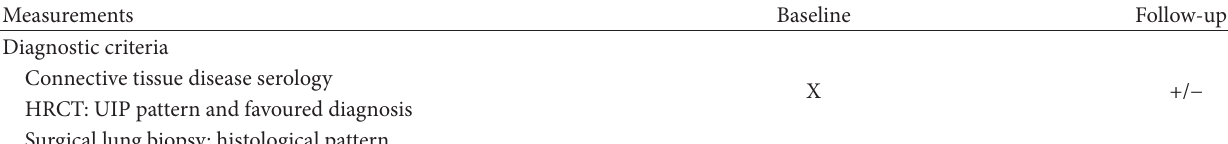
Table 2: Schedule of study